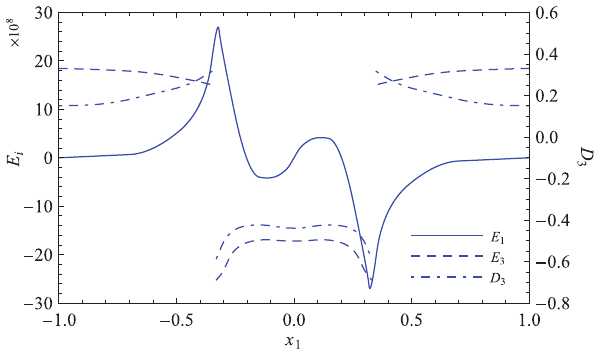
Figure 7 Variations of the total electric field, E displacement component, D